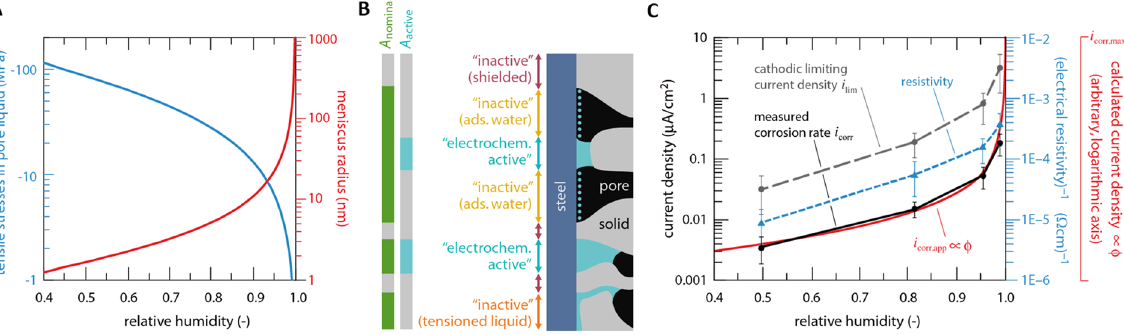
Figure 3. The amount of electrolyte available for electrochemical reactions at the steel surface depends strongly on RH and determines the apparent corrosion current density. ( A ) Tension of concrete pore liquid and radius of stably water filled pores as a function of RH, illustrating that with increasing RH, the amount of pore liquid behaving as electrolyte increases significantly; ( B ) schematic illustration of the electrochemically active steel surface in dense porous media depending on the porosity and the presence of electrolyte; green is the nominal area, that is the steel surface area not shielded by adherent solid phases; ( C ) Measured corrosion rate, cathodic limiting current density and the inverse of the electrical resistivity of the mortar as a function of RH (markers = average values, whiskers = standard deviations; based on all measured data). The predicted apparent corrosion current density (red), based on the capillary condensation theory and the concept of the electrochemically active area fraction, is in excellent qualitative agreement with these three parameters. Note the logarithmic scale, meaning that several orders of magnitude are expressed in this graph, following a distribution closely in agreement with how the electrochemically active area ratio ( φ ) is supposed to vary as a function of RH (red curve = qualitative plot of eq.